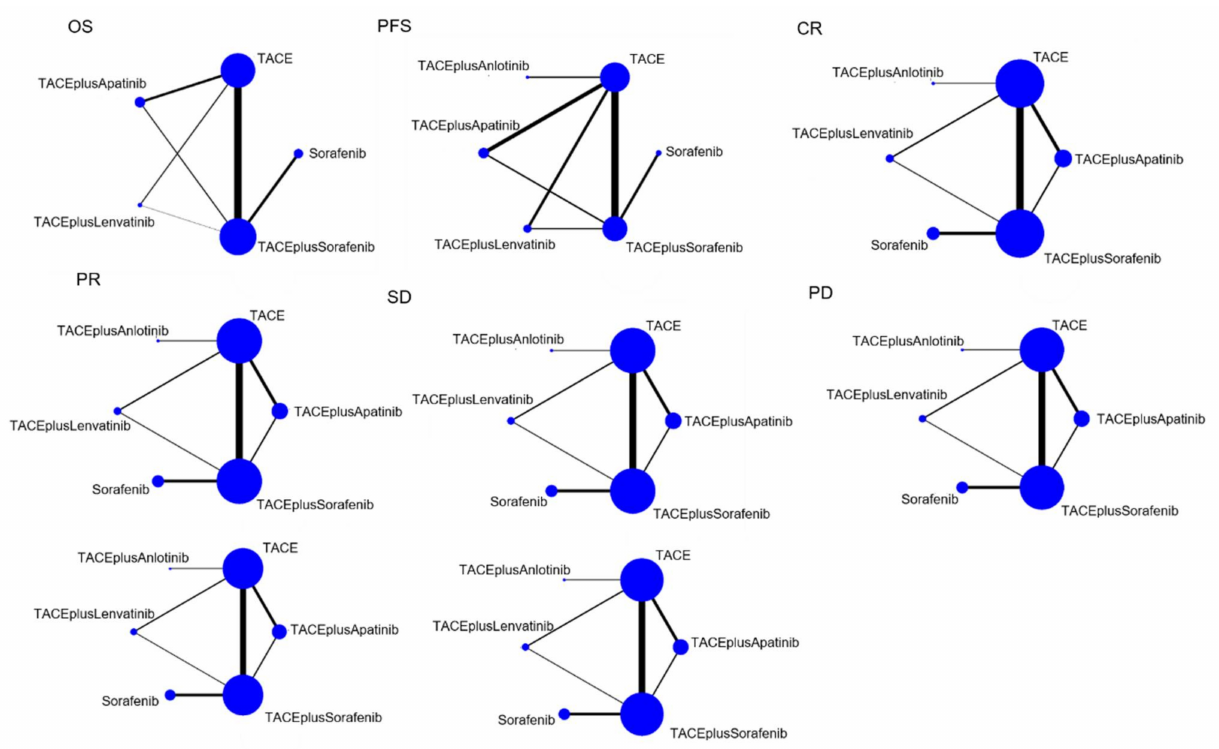
Figure 1. Network graph of the